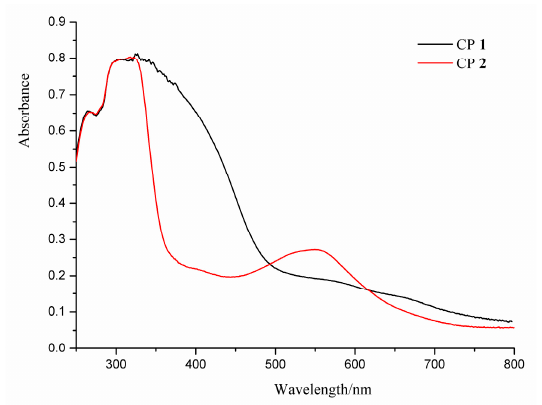
Figure 3. The UV–vis spectra for the CPs 1 - 2 .